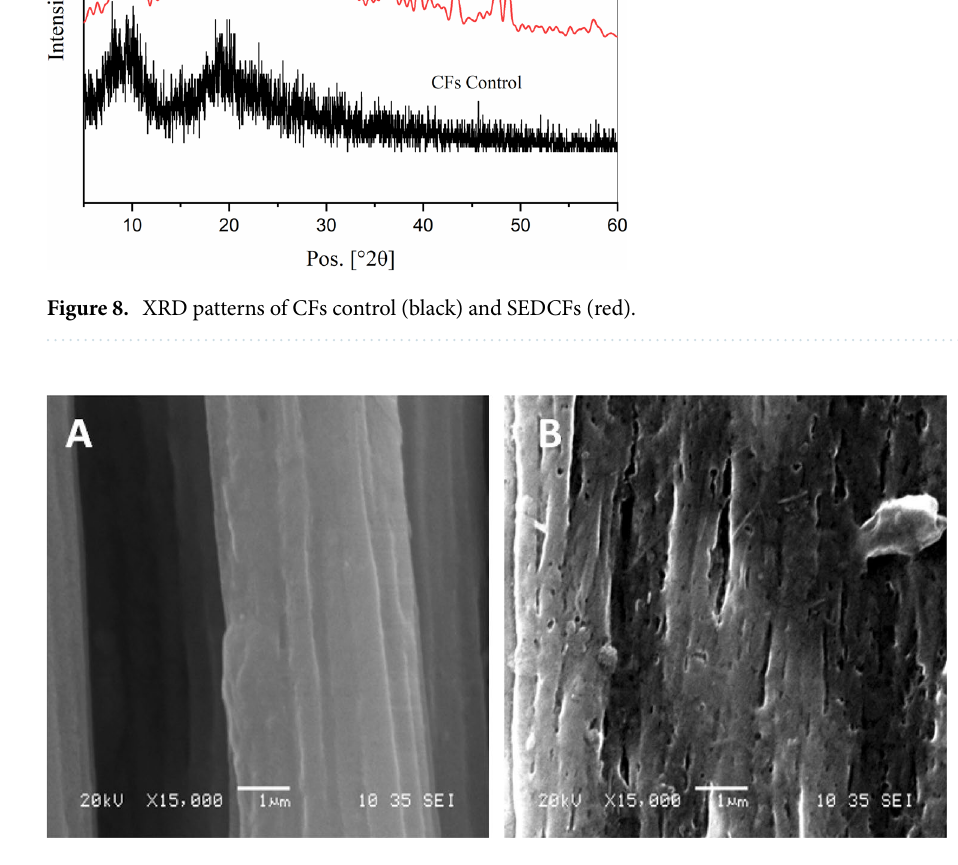
Figure 9. SEM photographs of CF S ( A ) and SEDCF S ( B ) at 15000X magnification power and 20 kV.